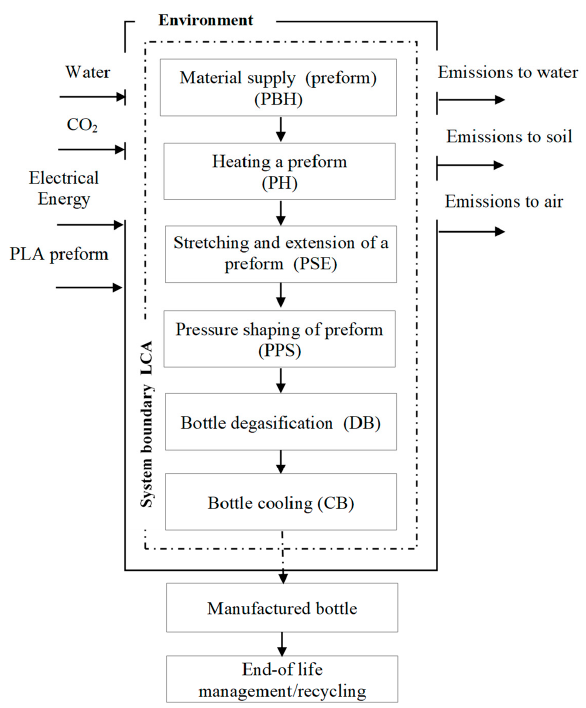
Figure 2. Boundaries of the accepted system [23].